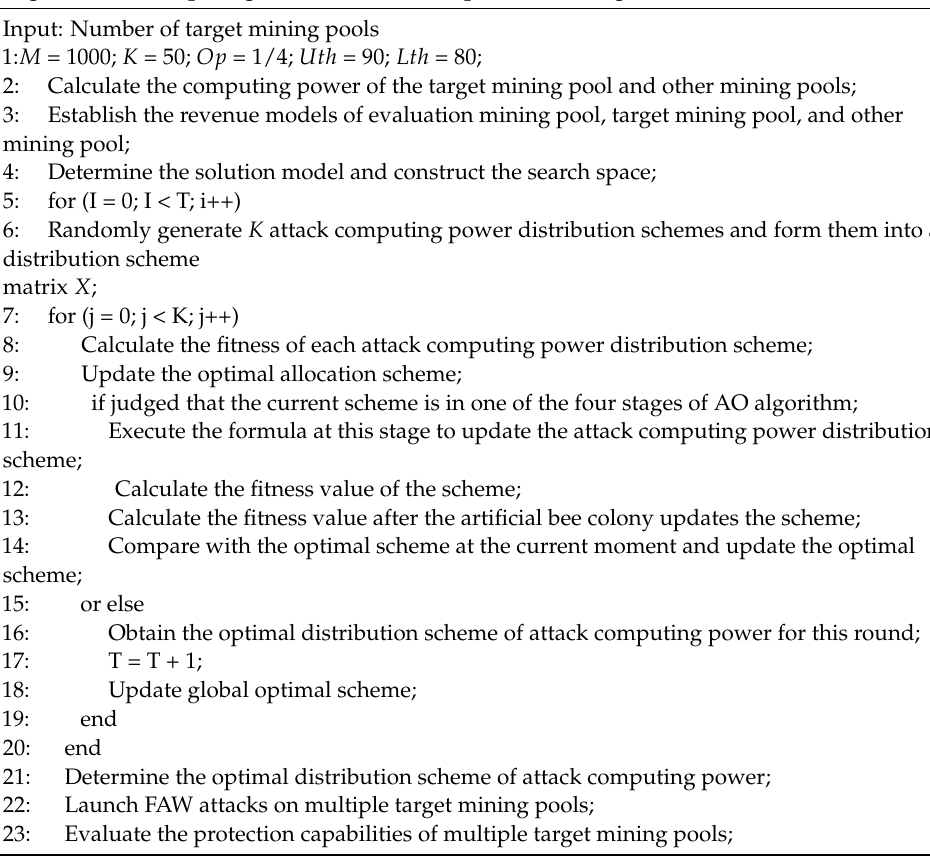
Algorithm 1: Computing Power Allocation Optimization Algorithm